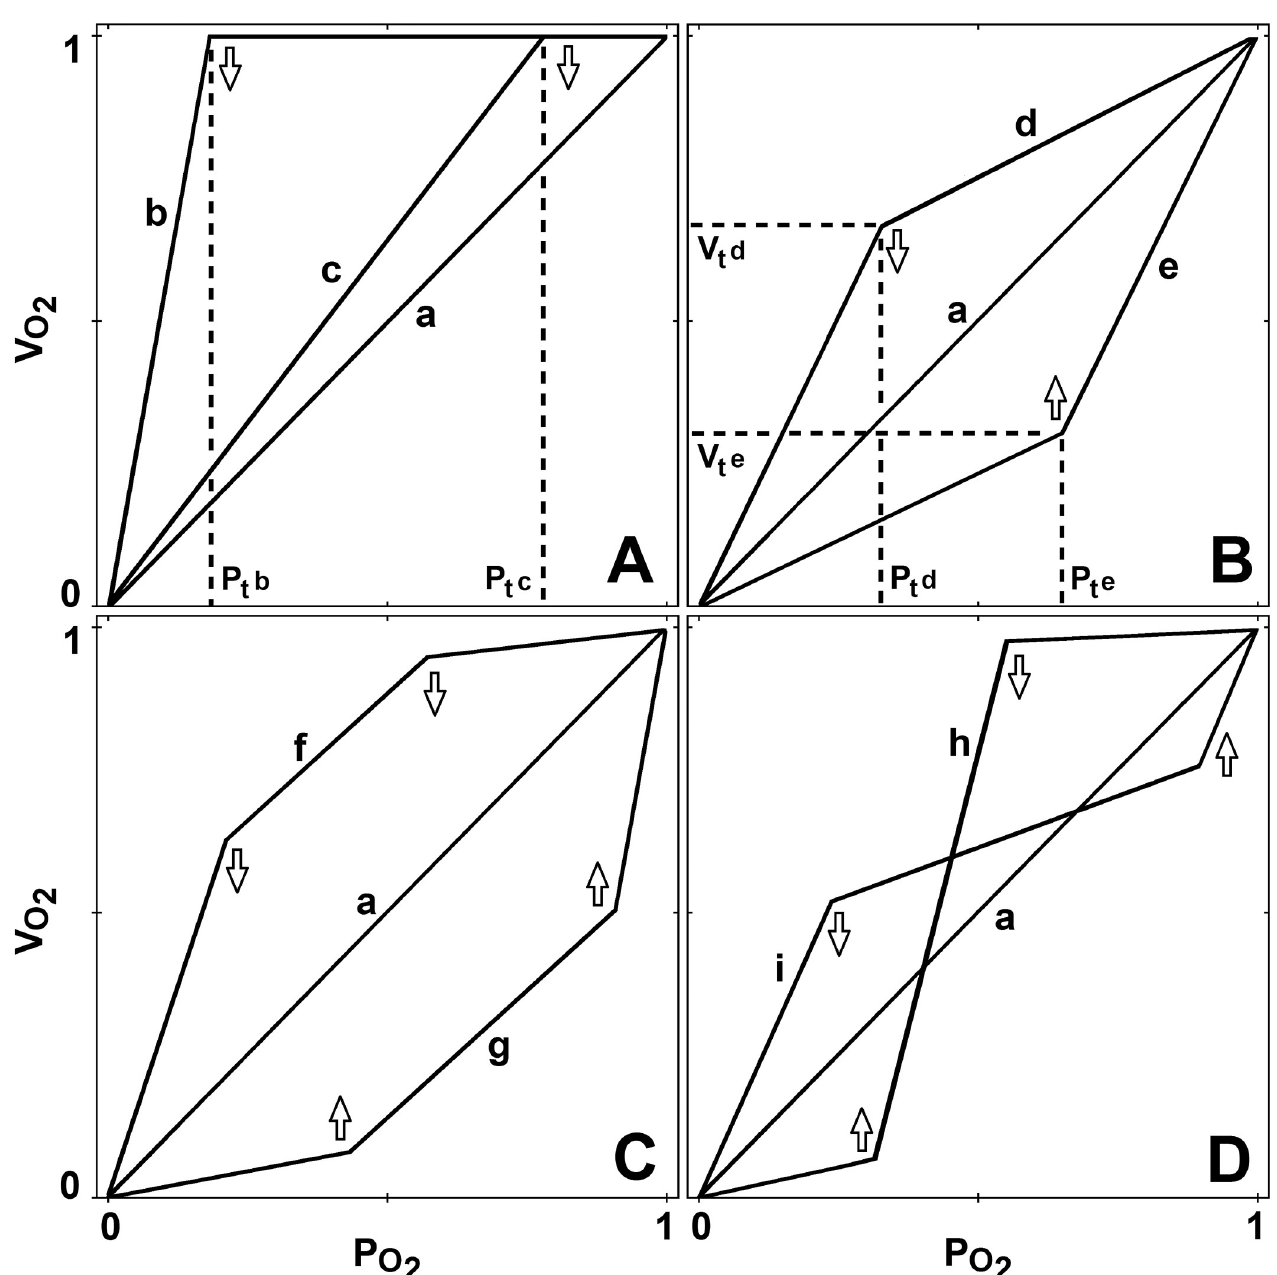
Fig 1. The nine curves (a through i) represent different segmented linear models for progressive hypoxia. Curve a represents a classic conformer and is model S1. Curves b and c represent classic regulation with b having more regulation than c and are both examples of model S2. Curve d represents partial regulation for x between P t,d and 1 and no regulation between 0 and P t,d and is an example of model S3. Curve e represents negative regulation for x between P t,e and 1 and no regulation between 0 and P t,e and is an example of model S3. Curves f , g , h , and i are all examples of model S4 and each have three linear segments labeled 1, 2, and 3 and all have no regulation in segment 1. Curve f has positive regulation in segments 2 and 3. Curve g has negative regulation in segments 2 and 3. Curve h has negative regulation in segment 2 and positive regulation in segment 3. Curve i has positive regulation in segment 2 and negative regulation in segment 3. The symbols # and " denote shift down and shift up threshold points, respectively.